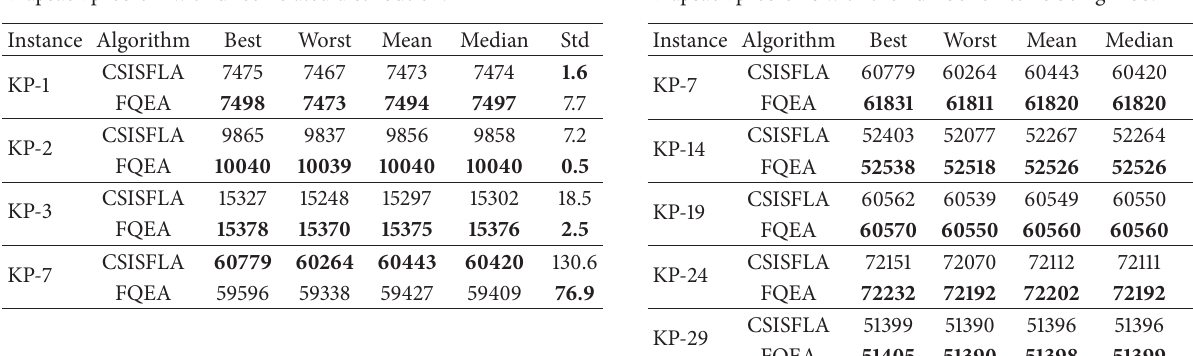
Table 7: Comparative study between CSISFLA and FQEA on 0-1 knapsack problem with uncorrelated distribution.